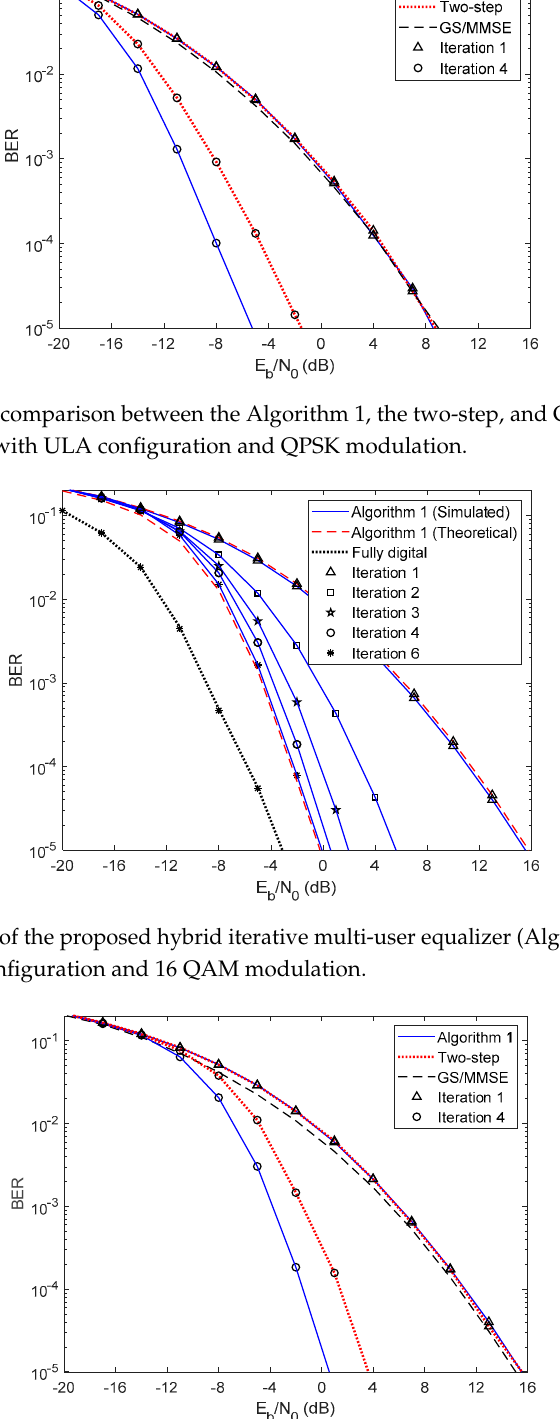
Figure 8. Performance comparison between the Algorithm 1, the two-step and GS / MMSE approaches